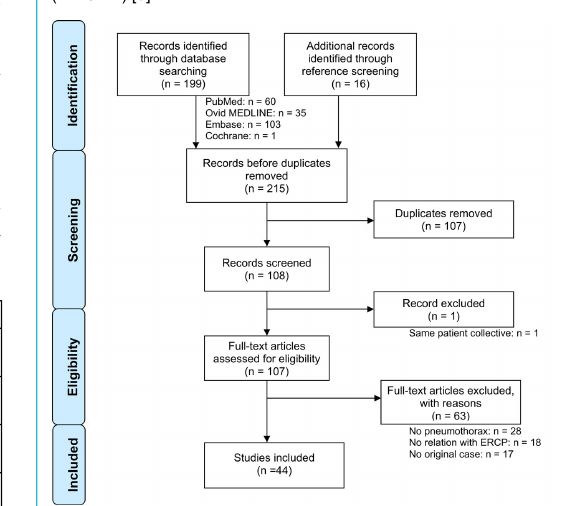
Figure 1: Flow chart of article selection, according to the Preferred Reporting Items for Systematic Reviews and